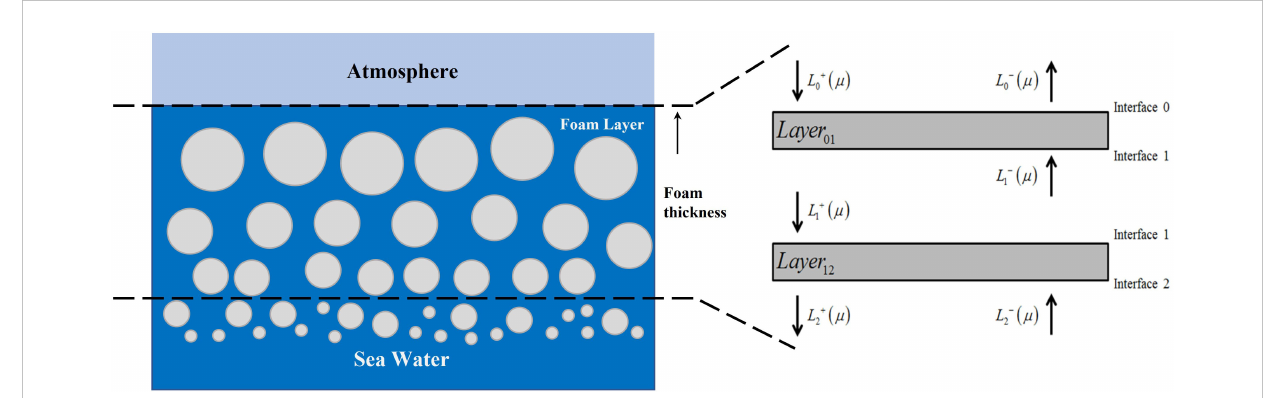
FIGURE 1 Geometrical con fi guration for thermal emission from the foam-covered